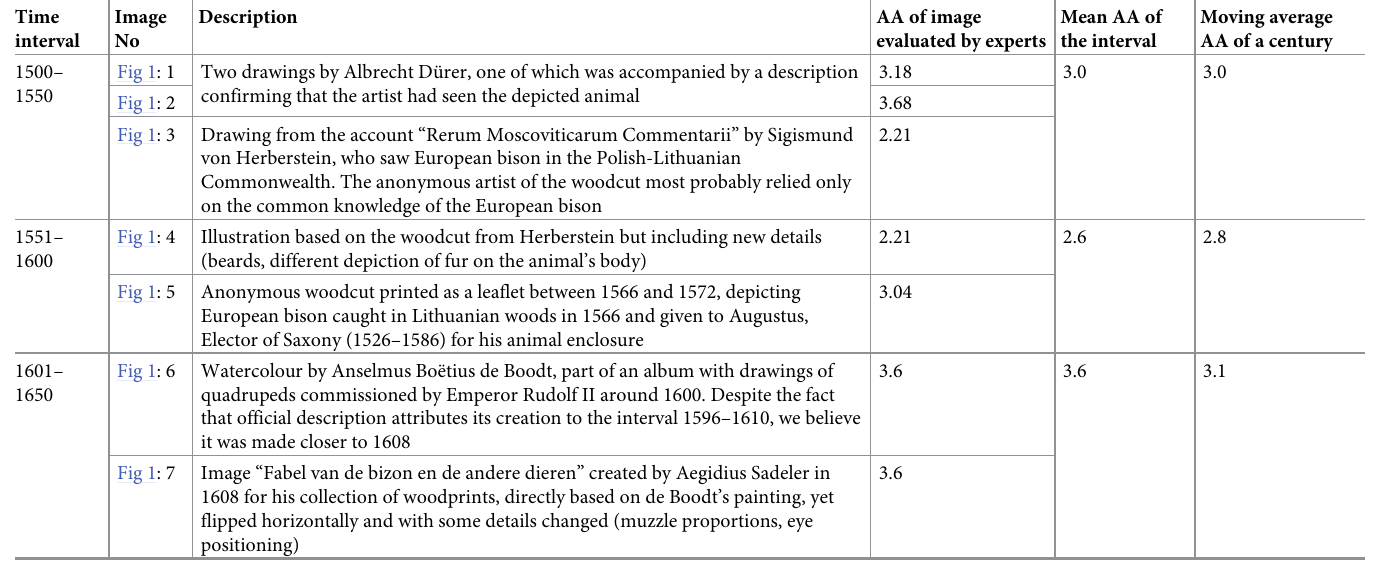
Mean AA of Moving average evaluated by experts the interval AA of a century